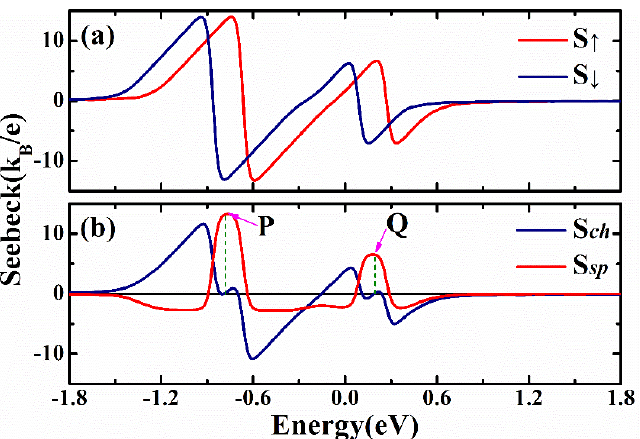
Figure 3. ( a ) Spin-dependent Seebeck coefficient for a zigzag phosphorene nanoribbon with a ferromagnetic stripe. ( b ) The corresponding charge and spin Seebeck coefficients. The parameters for the device are: gate voltages V g 1 = V g 2 = 0, exchange splitting M = 0.184 eV, and temperature k B T = 0.03 | t 1 |